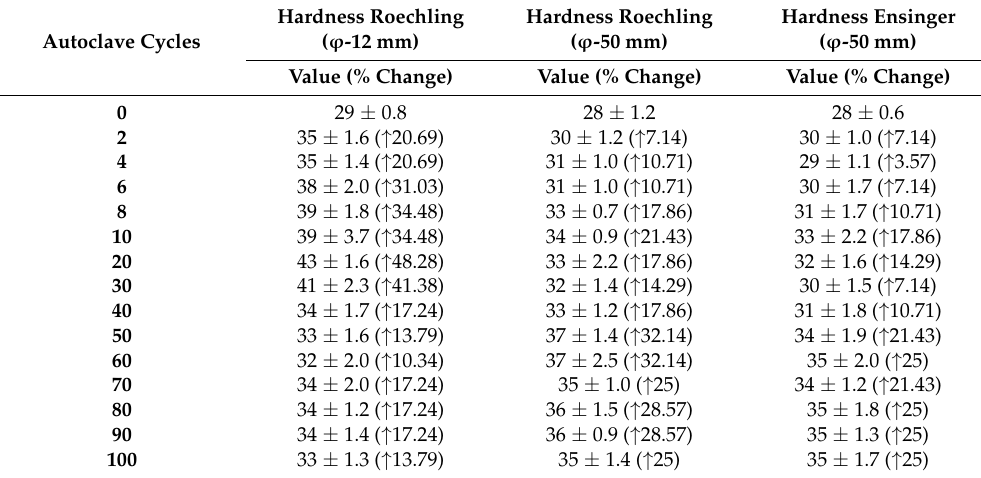
Table 2. Comparison of the hardness values of test samples manufactured from 12 mm and 50 mm rods and from two different PEEK